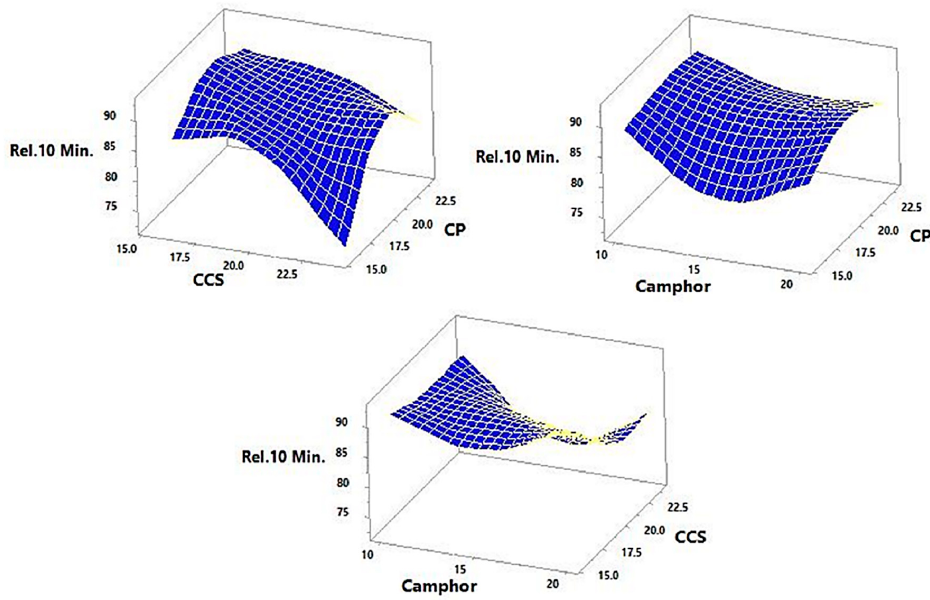
Figure 6. shows 3D and response surface plots for the effect of super ‐ disintegrates (X 1 and X 2 ) and total amount of sublimating agents (X 3 ) on the response Y 3 (%